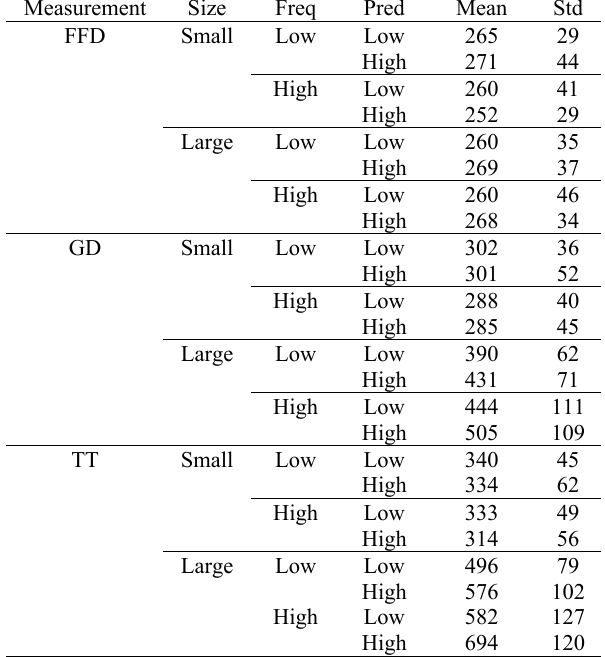
Table 3 Summary of mean and standard deviation (in ms) based on linguistic analysis